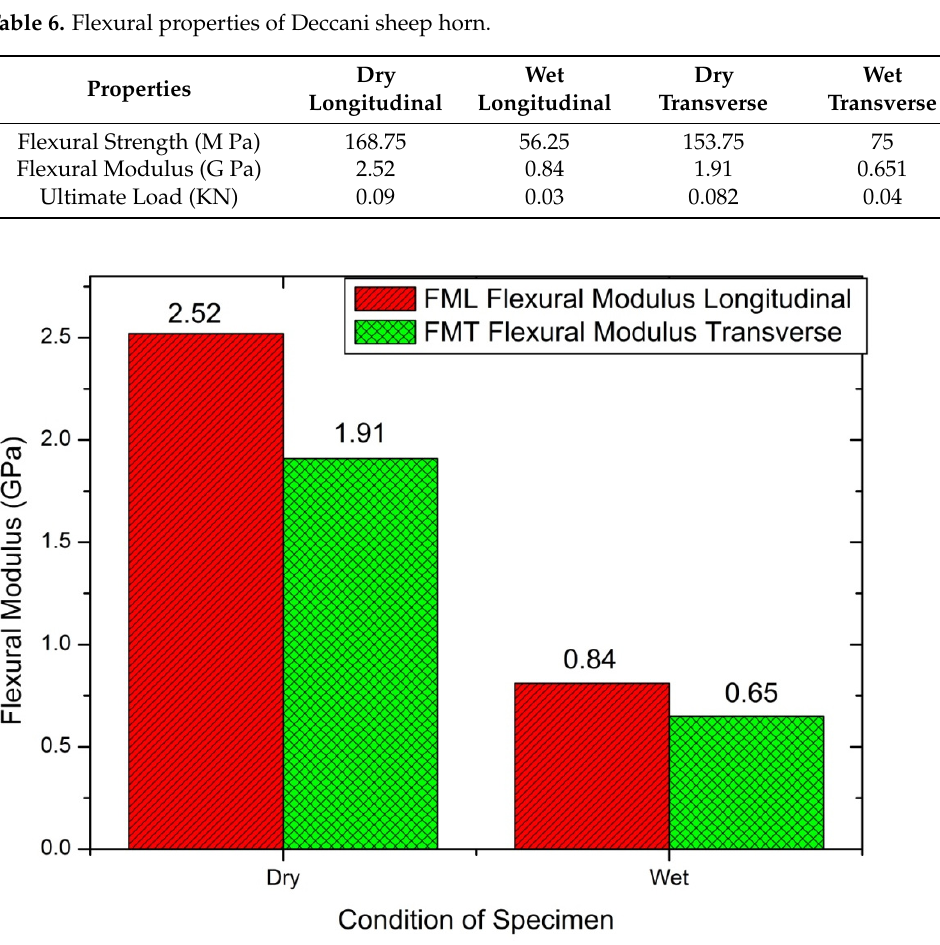
Figure 9. Maximum flexural strength determined by the three-point method for dry and wet condi- tion in the longitudinal and transverse directions. Table 7 represents the two-way ANOVA test results for flexural properties of Deccani sheep horns. When we compare all the F-values with critical values from the table it is clear that there is a significant effect of direction and condition on the flexural modulus of the Deccani sheep horn. Moreover, when we compare F-values and p -values for flexural